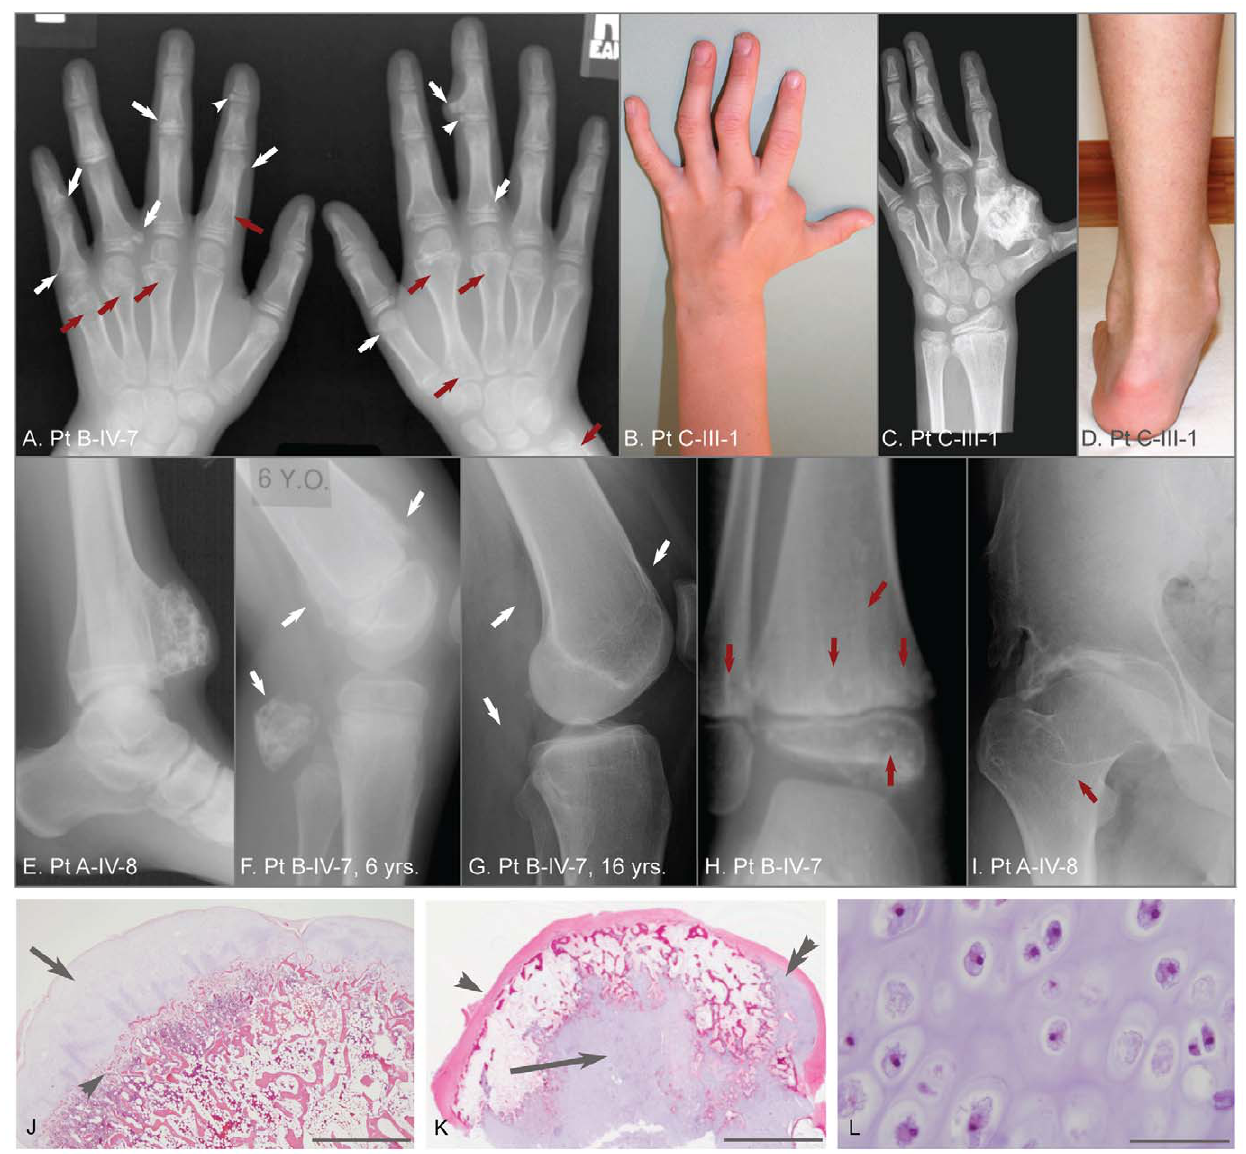
Figure 1. Clinical, radiographic, and histologic features of metachondromatosis. (A) Hand radiographs of participant B-IV-7, taken when 8- years-old. Exostotic lesions (white arrows) are present in the phalanges and metacarpals, and arise from the metaphysis (arrows) or epiphysis (arrowheads). Exostoses tend to point toward the adjacent joint. Endosteal lesions (red arrows) cause metaphyseal expansion. (B, C, D) Hand photograph and radiograph, and foot photograph of participant C-III-1 taken when 9-years-old, depicting mild shortening and deformity of the digits, a large exostotic lesion arising from the second metacarpal bone in the hand, and ankle enlargement superior to the malleoli due to exostoses of the tibia and fibula. (E) Ankle radiograph of participant A-IV-8 taken when 19-years-old depicting a recurrence of a previously excised exostotic lesion of the distal tibia that spans the physis. (F, G) Lateral knee radiographs of participant B-IV-7, taken at 6 years and 16 years, respectively. Note that multiple exostotic lesions of the distal femur and proximal fibula (white arrows) seen when 6-years-old (F) have regressed in the absence of surgical intervention by 16-years of age (G). (H) Ankle radiograph of participant B-IV-7, taken when 5-years-old, demonstrating radiolucency associated with endosteal lesions (red arrows) in the tibia and fibula, and mild metaphyseal flaring. Despite combined metaphyseal and epiphyseal involvement, this individual’s linear growth was not affected. (I) Hip radiograph of participant A-IV-8 taken when 22-years-old depicting an endosteal lesion of the femoral neck (arrow) that has caused degeneration of the femoral head and spurring of the acetabulum. (J) Low power photomicrograph of an hematoxylin and eosin ( H&E ) stained section through an exostosis that had been excised from a patient with hereditary multiple exostoses. Note this exostosis is a typical osteochondroma, having a well-developed surface cartilaginous cap (arrow) and endochondral bone immediately below (arrowhead). The scale bar represents 0.15 cm (K) Photomicrograph of an H&E stained exostotic lesion excised from participant A-IV-5 when 5-years-old. This lesion is predominantly covered by a fibrous cap (arrow) and has only a small, eccentric cartilaginous cap (double arrowhead). The majority of cartilage in this, and in 14 other exostoses from patients with MC that have been analyzed, is found within a central core (arrow) and has bone formation occurring at the periphery of this cartilage core. The scale bar represents 0.5 cm. (L) High-power image of the central cartilage core shows chondrocytes with prominent cytoplasm no organization typical of a growth plate. The scale bar represents 100 m m.